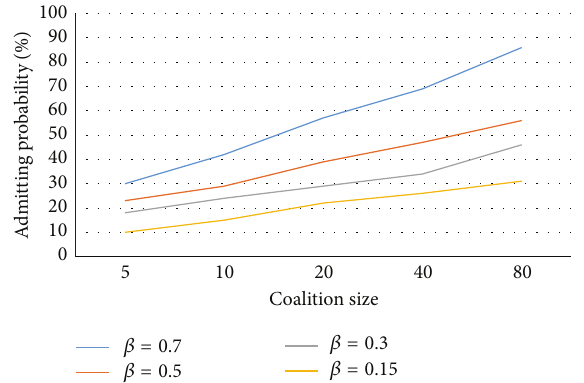
Figure 13: Admitting probability for different coalition size and beta values.